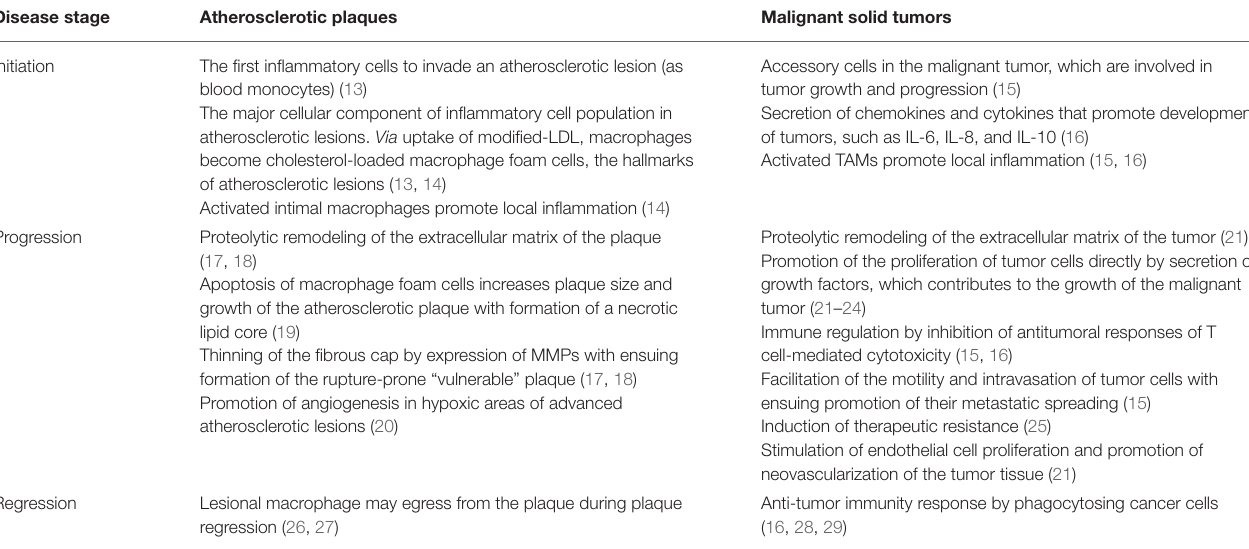
TABLE 1 | Effects of macrophages during the various developmental stages of atherosclerotic plaques and malignant solid tumors. Disease